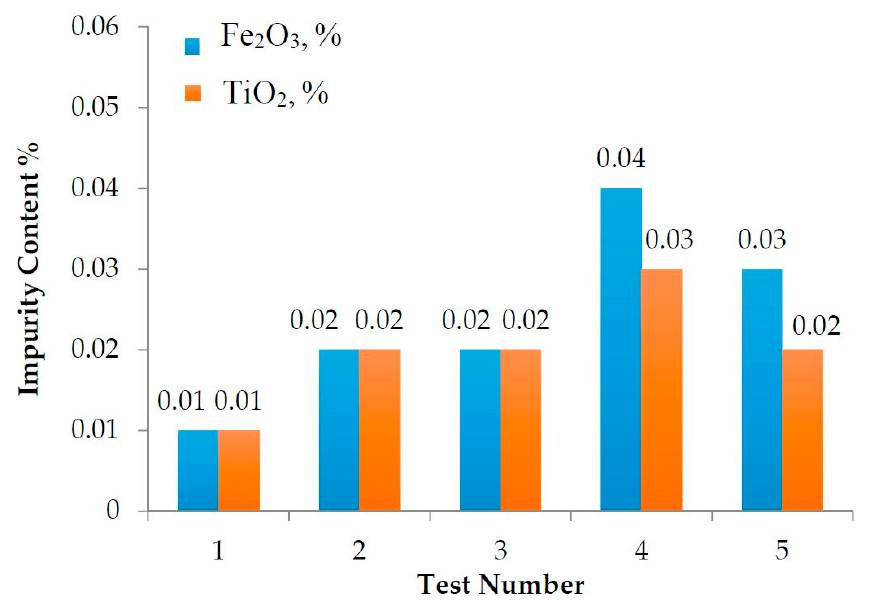
Figure 7. Impurity content of quartz concentrates for each test.